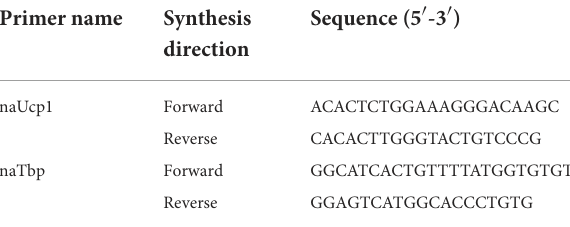
TABLE 1 Oligonucleotide primer sequences for